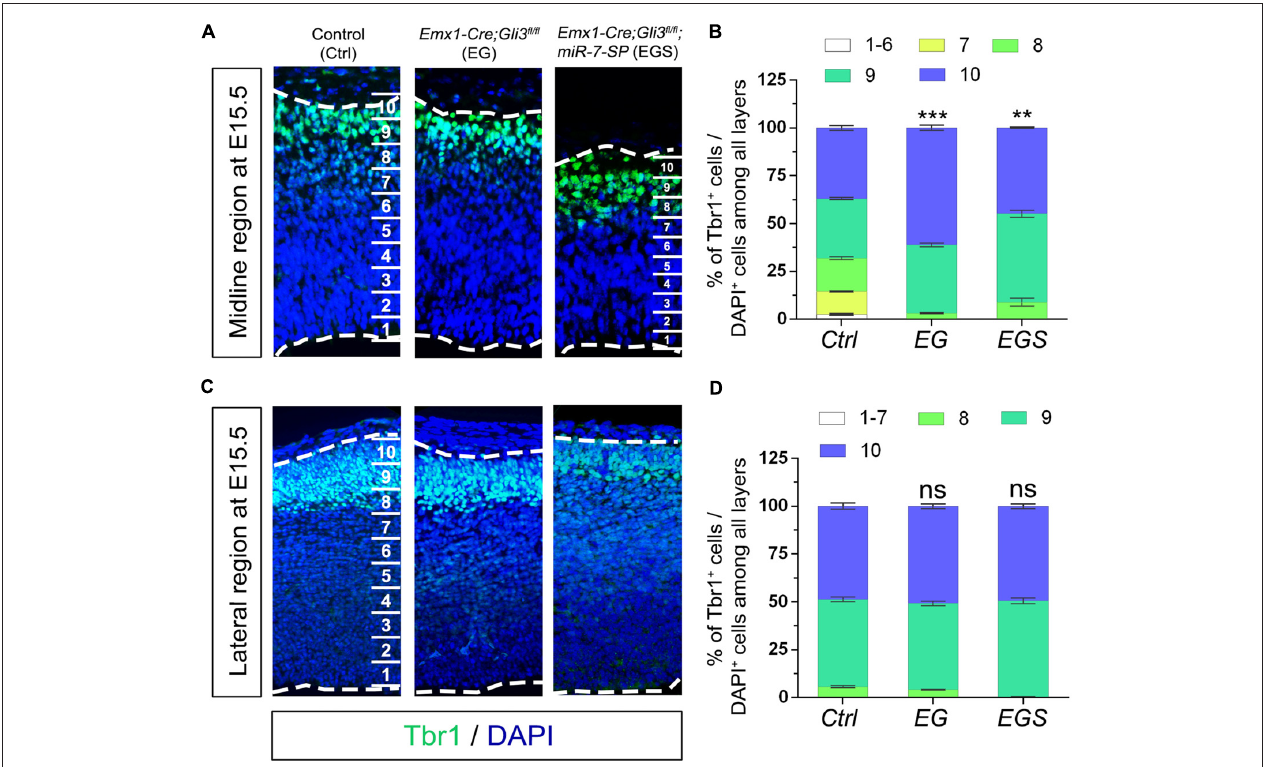
FIGURE 6 | The regulatory role of Gli3 and miR-7 in neuronal migration in E15.5 cortices. (A,B) Absence of Gli3 facilitated more Tbr1 + marked neurons to migrate into the upper-bins (bin10) in the midline region, while double-lose of miR-7 and Gli3 corrected the migratory process. (C,D) No significant alteration of migratory process was detected in the bin10 in the lateral region in EG and EGS cortices. The markers BrdU, Tbr1 and DAPI stained for proliferative NPs, newborn neurons and all cells, respectively. Values represent mean ± SEM. n > 9. ∗∗ P < 0.01; ∗∗∗ P < 0.001; ns, not significant. One-way ANOVA with post hoc test was used. Scale bar = 50 µ